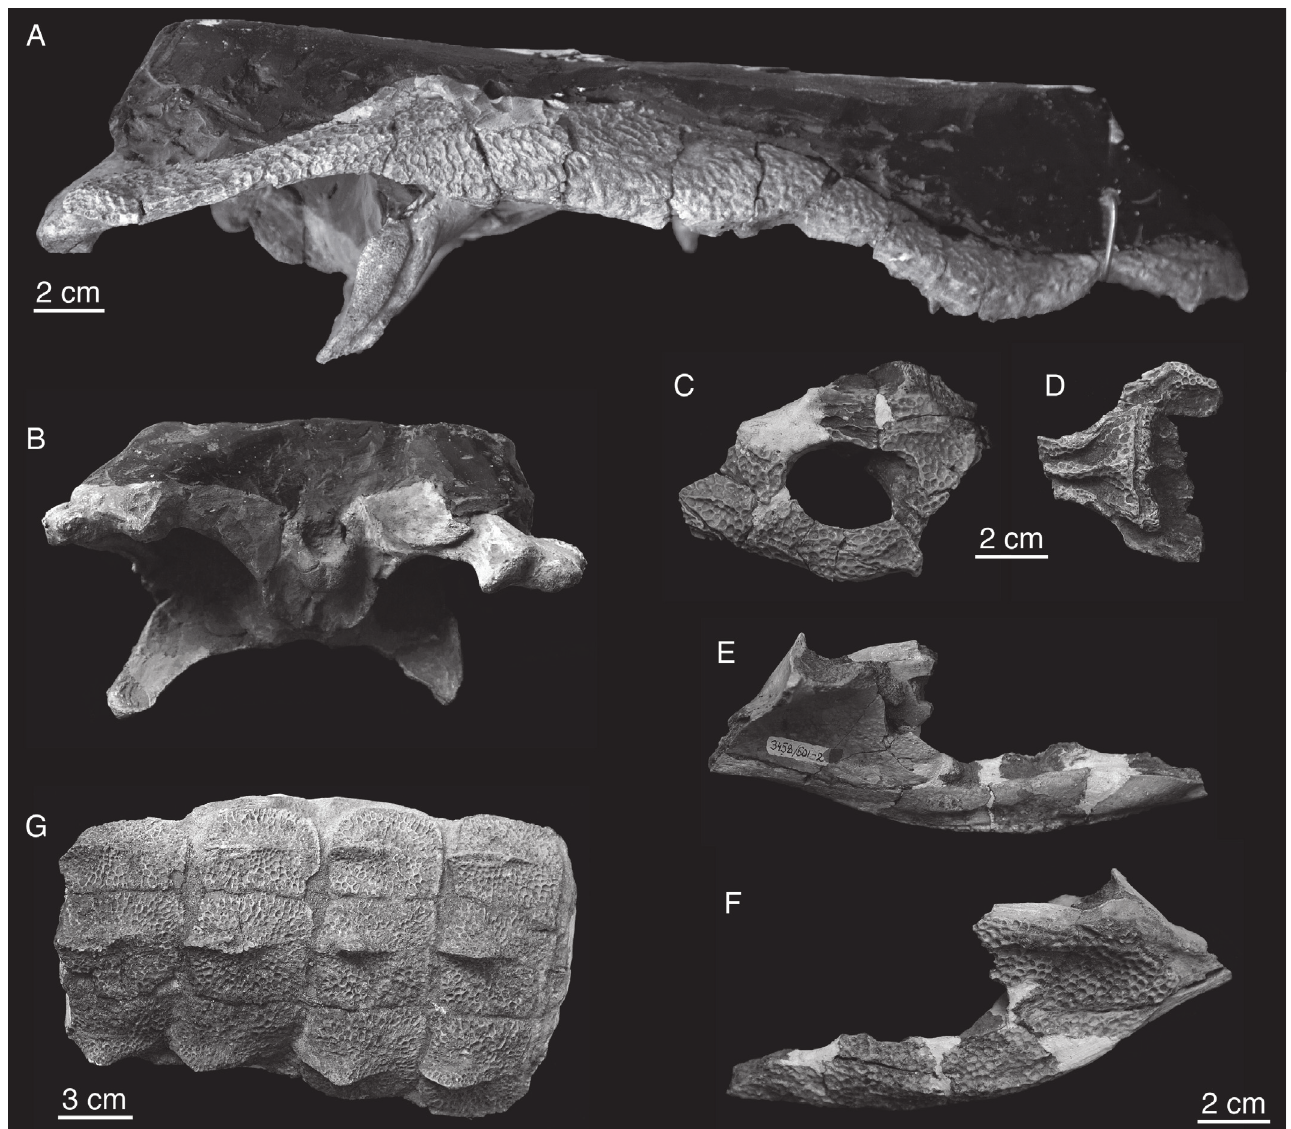
Fig 9. PIN 3458/501, Shamosuchus ulgicus (= Paralligator gradilifrons ). A , skull in right lateral view; B , skull in posterior view; C , partial skull table dorsal view; D , frontal with partial prefrontals and lacrimals in dorsal view; E , posterior portion of mandible in medial view; F , posterior portion of mandible in lateral view; G , dorsal osteoderms in dorsal